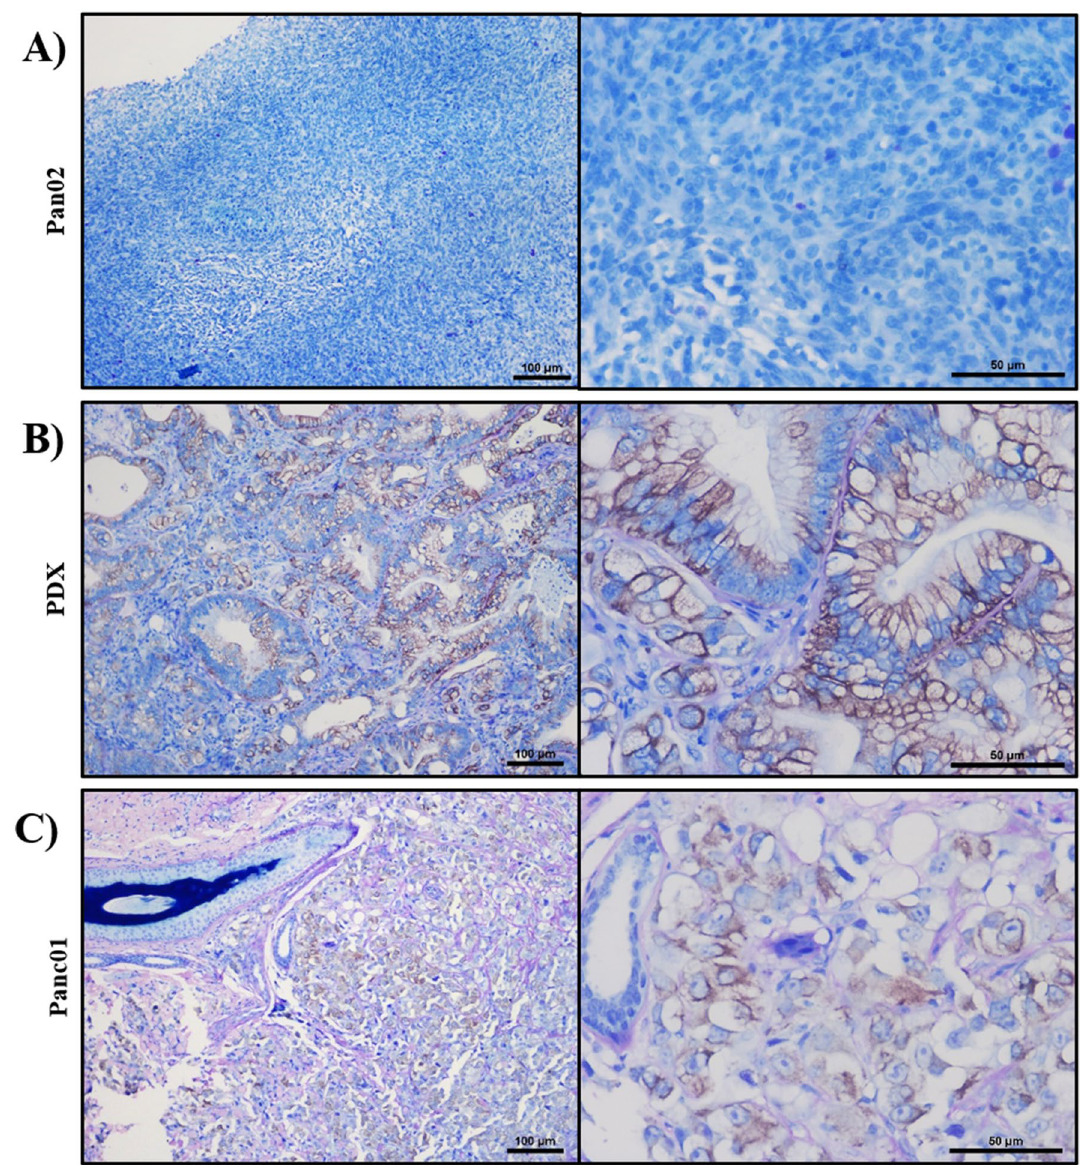
Figure 6. Immunohistochemical confirmation of ductal cells in pre-clinical pancreatic cancer animal models. ( A ) mouse Pan02, ( B ) human PDX, and ( C ) human Panc01 were compared for CK19 expression. Brown color indicates positive color. Nuclei are stained in dark blue, and remaining cell features are highlighted in light